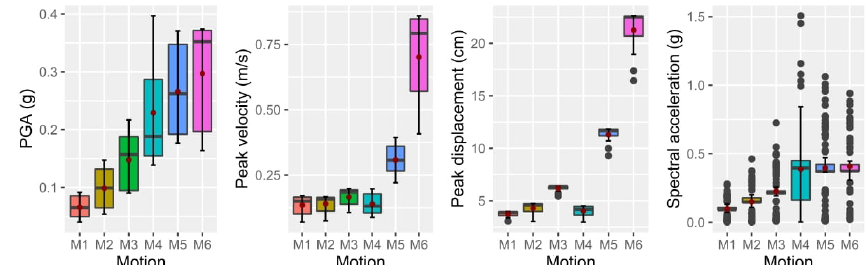
Figure 12. Box and whisker plot for ground motion parameters of soil profile at P1 Toorsa II in Zone I.